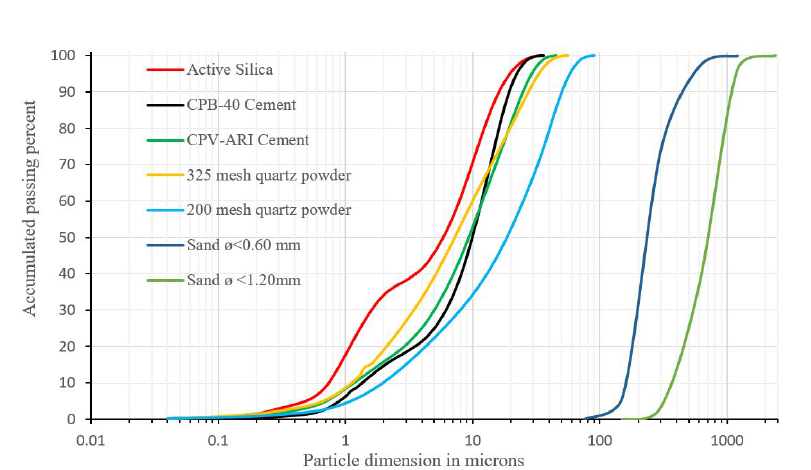
Figure 2. Particle size distribution of cement, active silica, quartz powder and fine aggregate